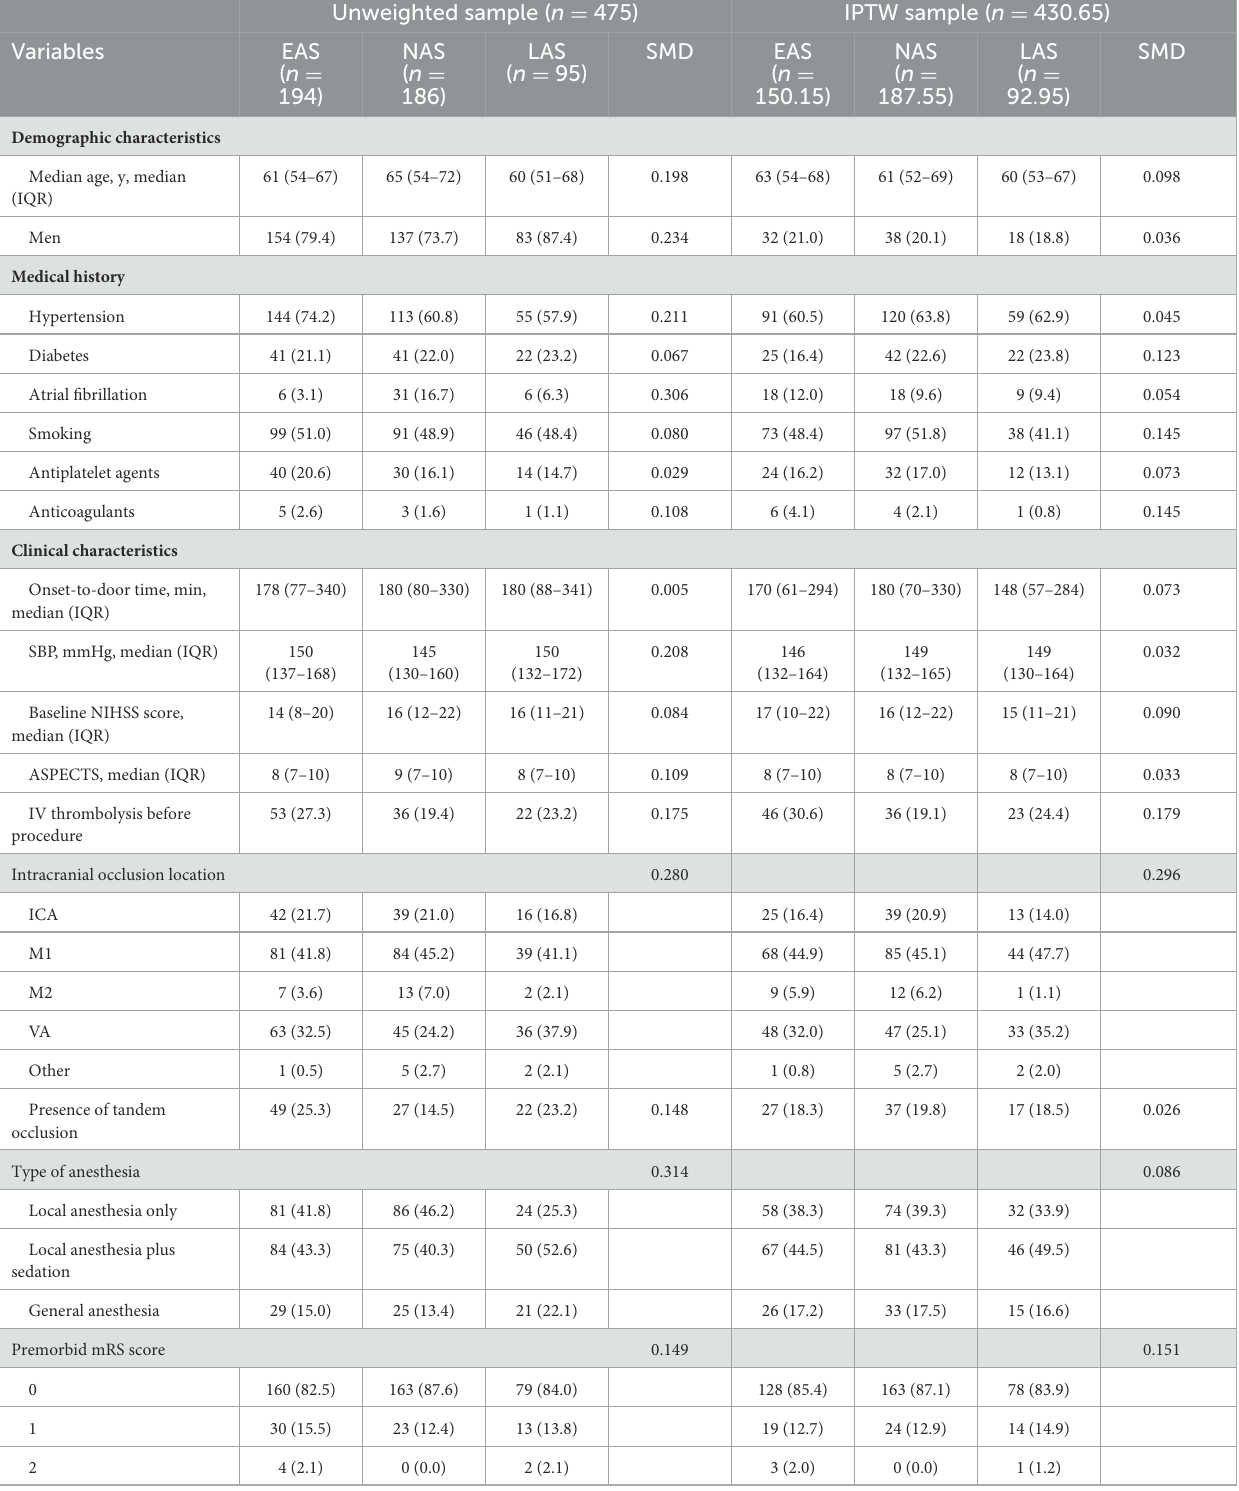
TABLE 1 Baseline characteristics of EAS, NAS, and LAS groups before and after inverse probability of treatment weighting ∗ . Unweighted sample ( n = 475) IPTW sample ( n =